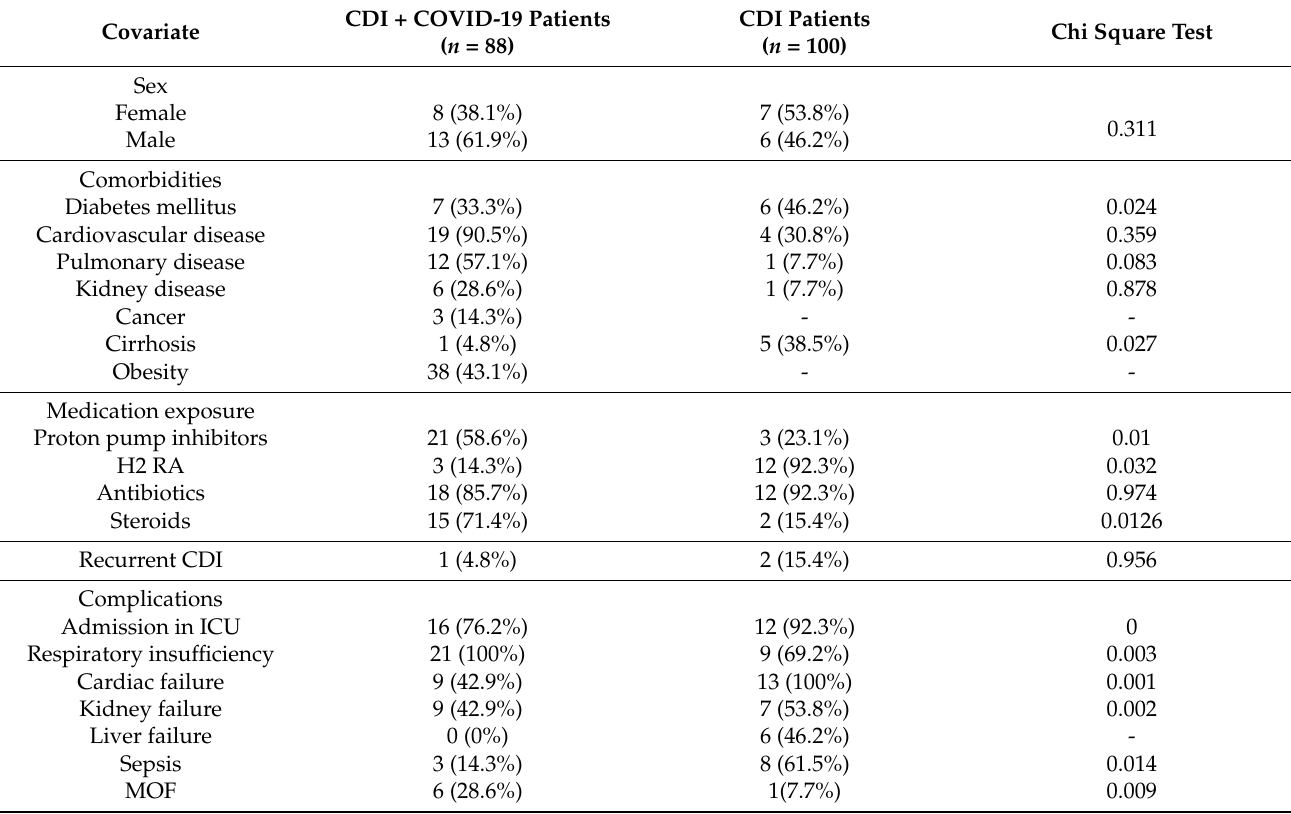
Table 3. Univariate analysis of risk factors for a poor prognosis (death) in both groups.